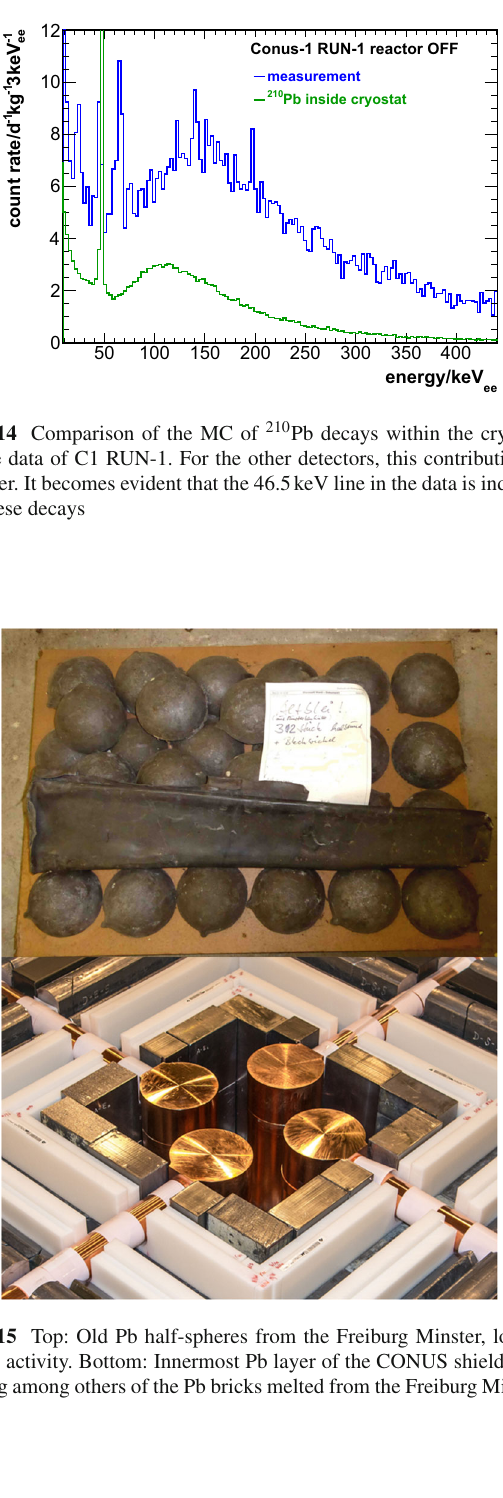
440]keV ee the rate is 209d − 1 kg − 1 (measured overall back- ground 400–800d − 1 kg − 1 ). The spectrum of this contribu- tion in the highE range including the 46.5keV line is shown in Fig.14.